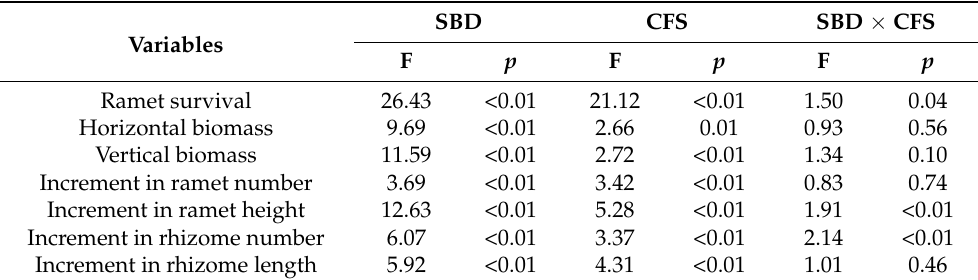
Table 1. Results of general linear model (GLM) on the effects of sand burial depth (SBD), clonal fragment size (CFS), and their interaction (SBD × CFS) on ramet survival and growth of Phragmites communis . The p values in bold indicate the significant differences at the 0.05 level.